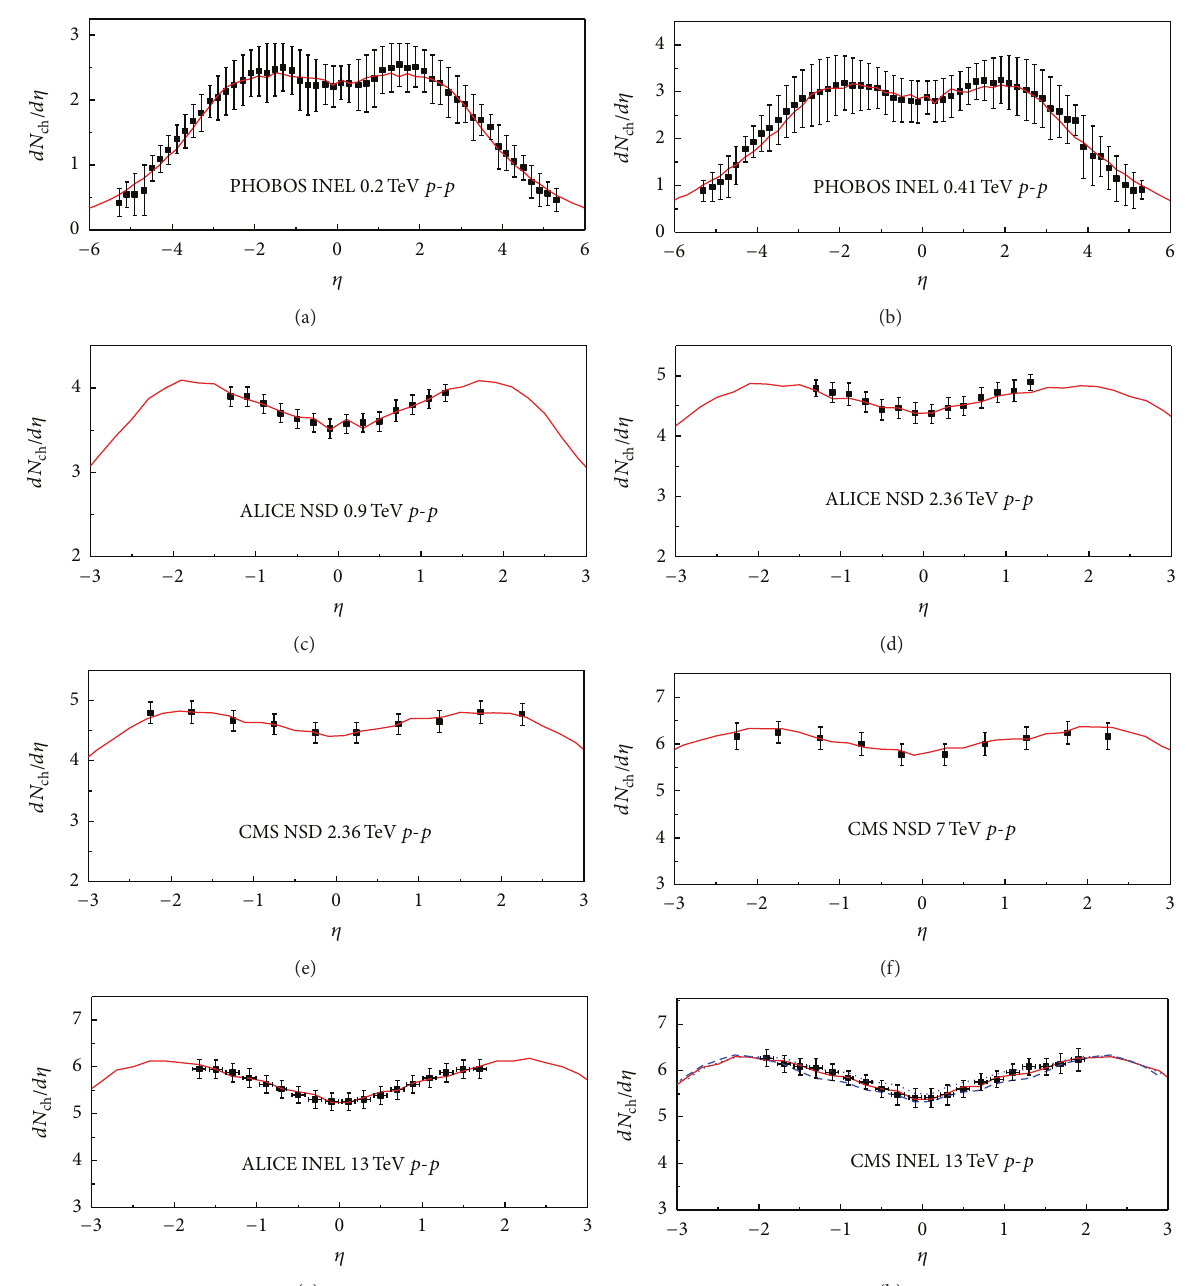
Figure1:Pseudorapiditydistributionsofchargedparticlesproducedin 𝑝 - 𝑝 collisionsathighenergies.Thesquaresrepresenttheexperimental data of the PHOBOS [34] ((a), (b)), ALICE [35, 36] ((c), (d), (g)), and CMS [37, 38] ((e), (f), (h)) Collaborations, whereas the curves represent our fitted